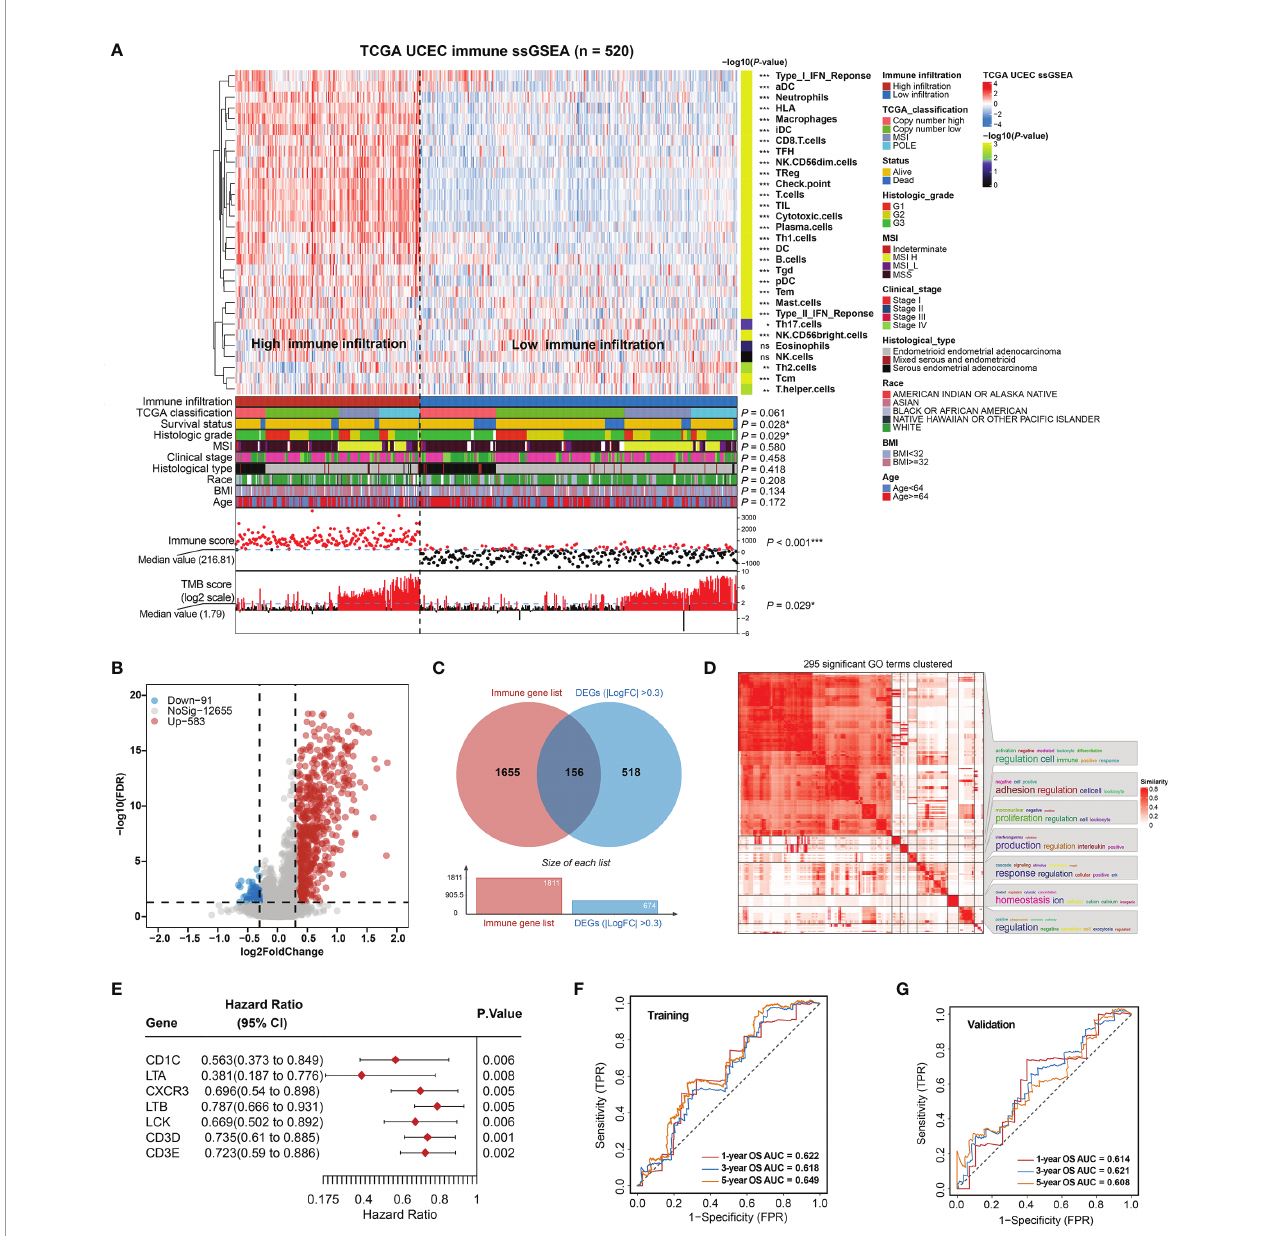
FIGURE 1 | Construction of total immune signatures and Immune In fi ltration Risk Model (IIRM). (A) SsGSEA results of 520 EC specimens, organized by total immune cell in fi ltration levels and immune scores. Unsupervised consensus clustering grouped gene sets into two major categories based on total immune cell in fi ltrations. Clinicopathological characteristics of the 520 EC patients are shown in the annotation, and different colors represent the characteristics and subtypes. The statistical differences in variables between two clusters were compared using the Fisher ’ s exact test. * p < 0.05, ** p < 0.01, *** p < 0.001. (B) Volcano plots of the distribution of the DEGs between high- and low-immune in fi ltration groups. Red and blue represent upregulated and downregulated genes, respectively. Genes with |log2FC| > 0.3 are annotated in the plot. (C) Venn diagram depicts the overlap of the genes involved in immune genes and DEGs of total immune in fi ltration. (D) The 295 signi fi cant GO terms clustering in the DEGs between high- and low-immune in fi ltration groups. There are word cloud annotations on the right side of the heatmap that summarize the features with keywords in each GO cluster. The color shade re fl ects the similarity of the pathway enrichment, while different dimensions represent the size of the enrichment. (E) Forest plot of the univariate analyses for seven signi fi cant immune- related DEGs of total immune in fi ltration with overall survival ( p < 0.01). (F) ROC curve of the prognostic values of IIRM training group in 1-, 3-, and 5-year OS with AUC = 0.622, 0.618, and 0.649, respectively. (G) ROC curve of the prognostic values of IIRM validation group in 1-, 3-, and 5-year OS with AUC = 0.614, 0.621, and 0.608, respectively. ns, non signi fi